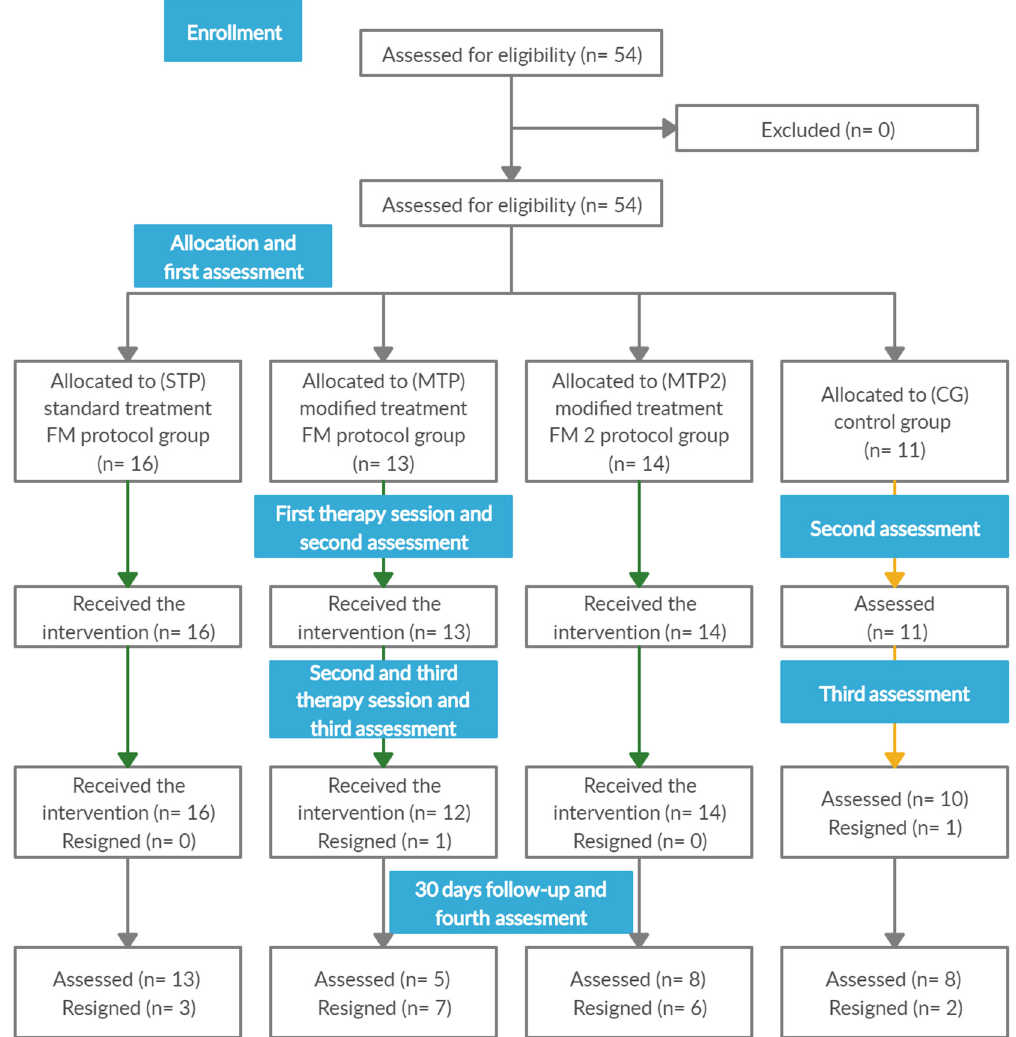
Figure 3. Flow of the participants through the trial.